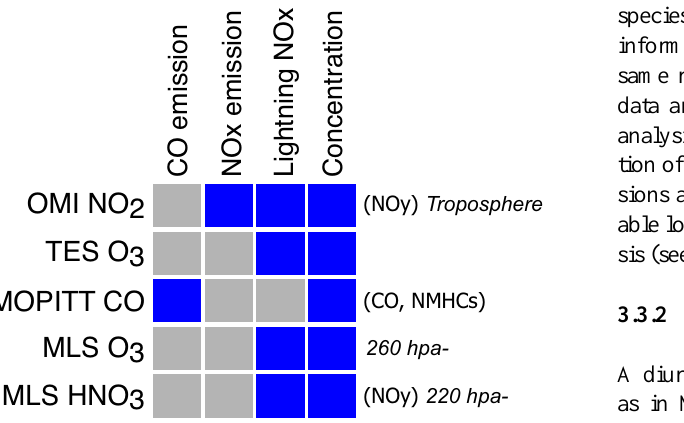
Fig. 2. Schematic diagram of the correlation matrix between ob- servations and the state variables. Satellite data used for the data assimilation are listed in the left column. The model variables up- dated during the data assimilation are listed in the top row. The blue (gray) colour indicates that correlations between the observed vari- ables and the model variables are considered (neglected using the variable localization technique). See Sect. 3.3 for